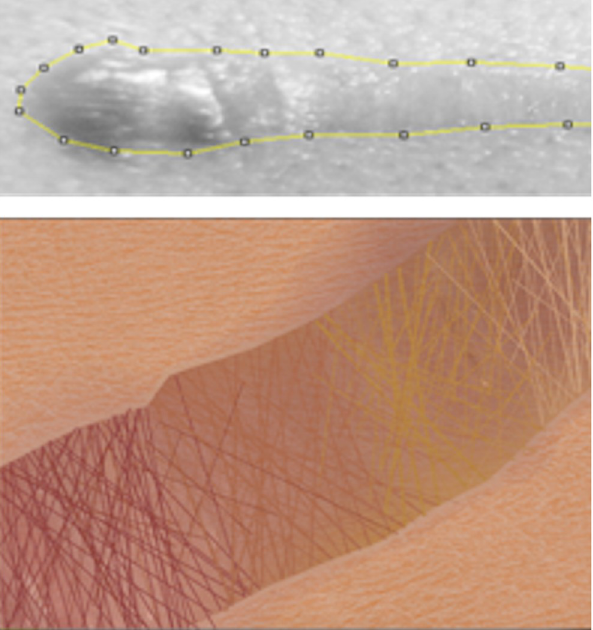
Fig 5. A collaborative photo journal project. A DIVAS scholar used ImageJ to analyze images of a healing wound (top) while a design student created a composition depicting the healing process (bottom).